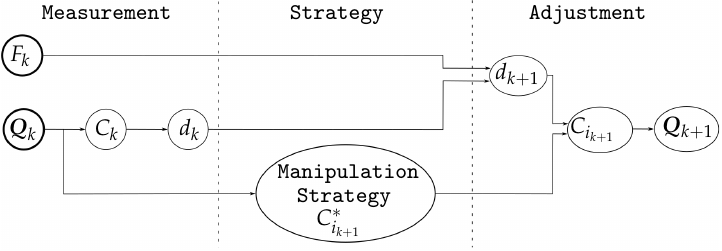
Figure 3. Relation between the measured variables, the role of the manipulation strategy, and the final adjustment to obtain the new hand